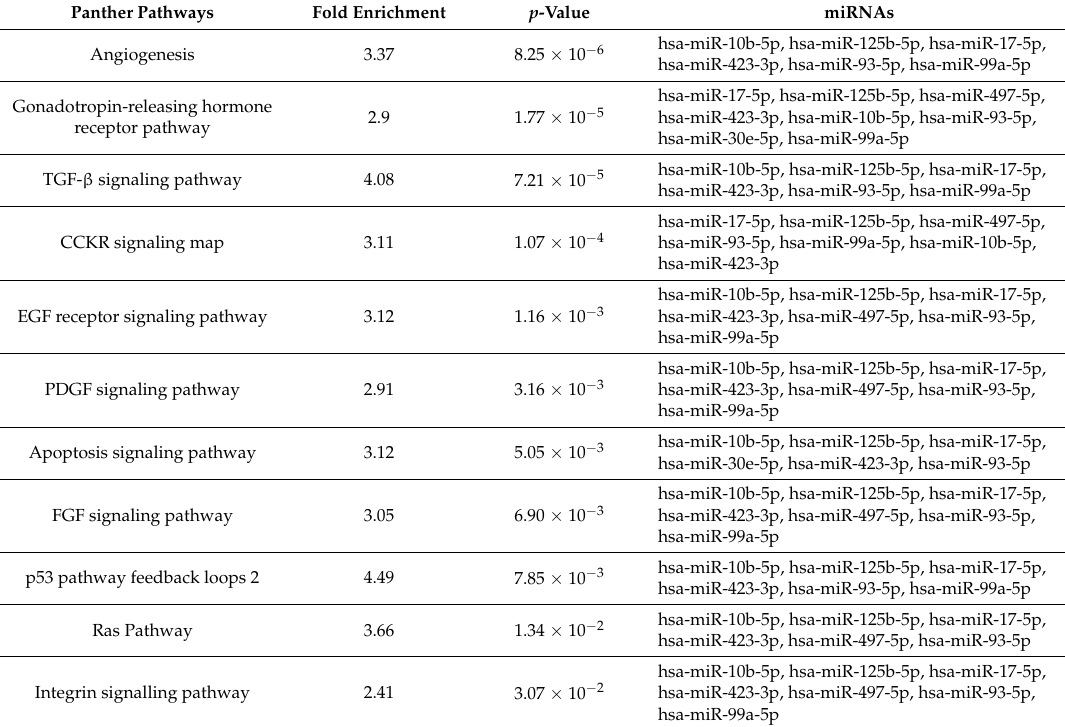
Table 3. Enriched pathways associated with the validated target genes of the eight miRNAs with altered expression levels during the first five years after